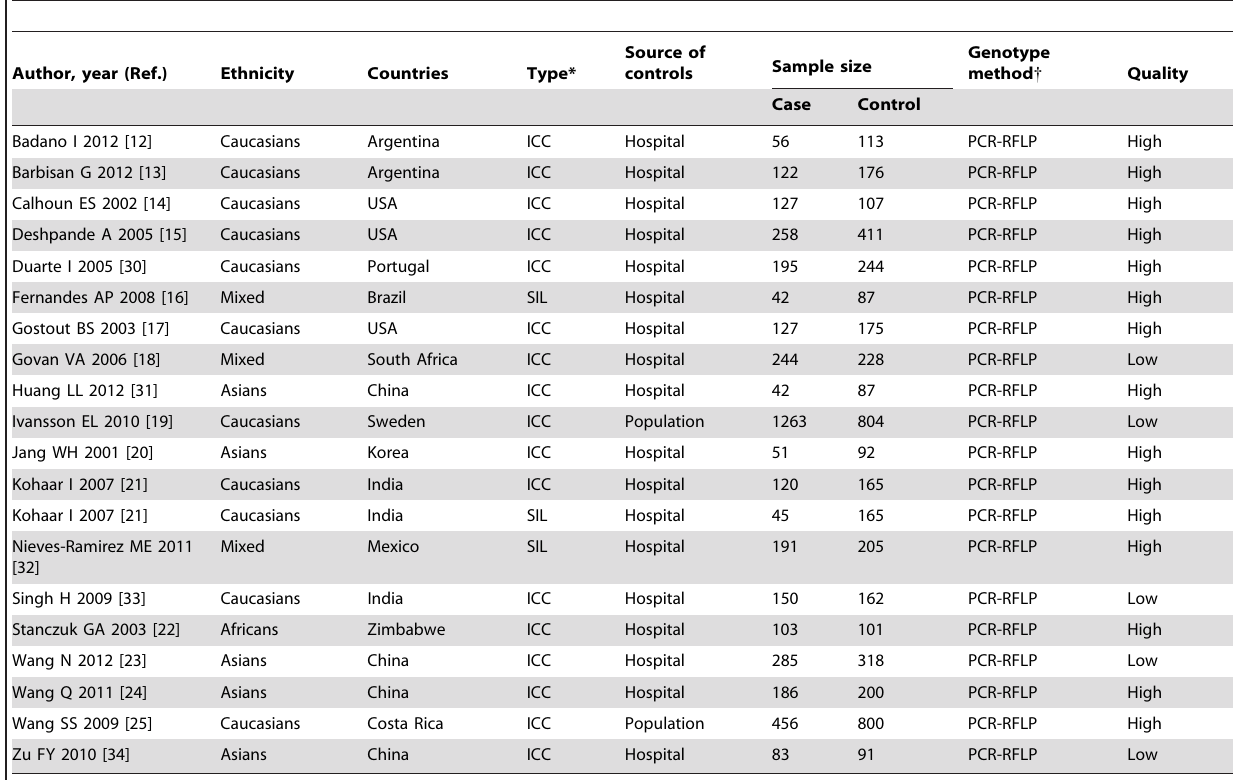
( { PCR-RFLP, Polymerase chain reaction restriction fragment length polymorphism; *ICC, Invasive cervical cancer; SIL, squamous intraepithelial lesions.)